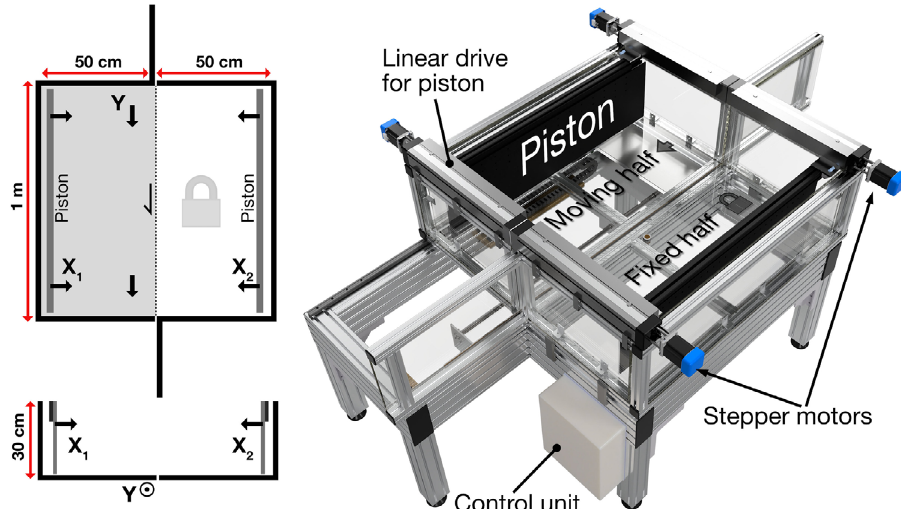
Fig. 2 Illustration of the MultiBox . 3D rendering of the MultiBox and sketches showing box dimensions with displacement components of the pistons ( X 1 and X 2 ) and the velocity discontinuity (dotted line) between the box halves ( Y